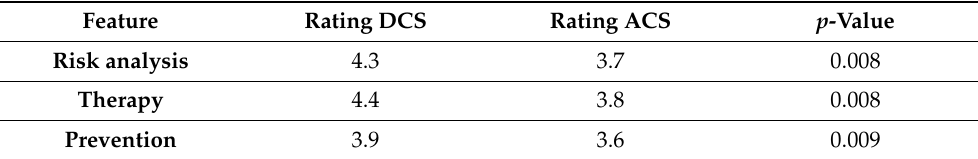
Table 4. Detailed answers in the Likert scale to the question of “In which more general sectors do you think artificial intelligence is